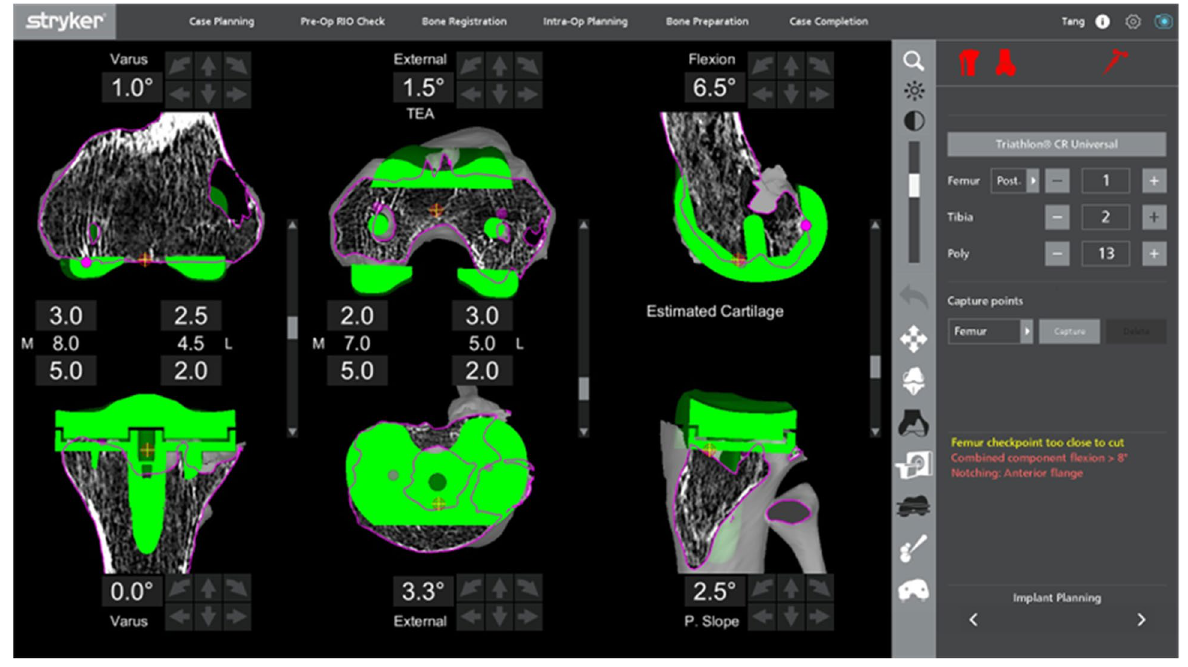
Fig. 15 Preoperative planning of a patient with antibiotic cement spacer for periprosthetic joint